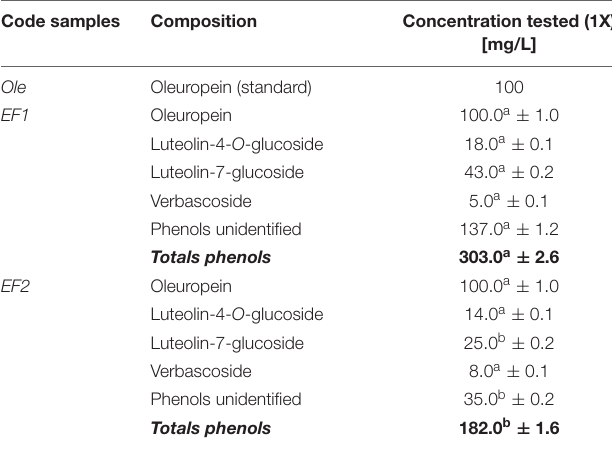
TABLE 1 | Phenolic compounds (Oleuropein – Ole ; leaf extract 1 – EF1 ; leaf extract 2 – EF2 ) used as free or encapsulated in CSNPs, for in vitro assays against Fusarium proliferatum